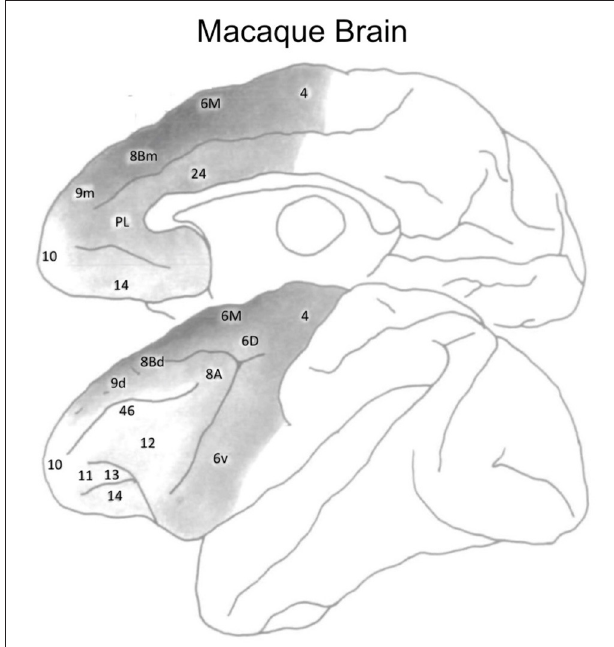
FIGURE 5 | Dopaminergic axon density in the macaque monkey frontal cortex. Darker shades of gray denote a higher density. Figure adapted from Williams and Goldman-Rakic (1993), with permission from the